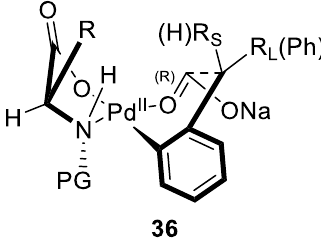
Figure 5. The proposed transition state. Reproduced from Reference [81].